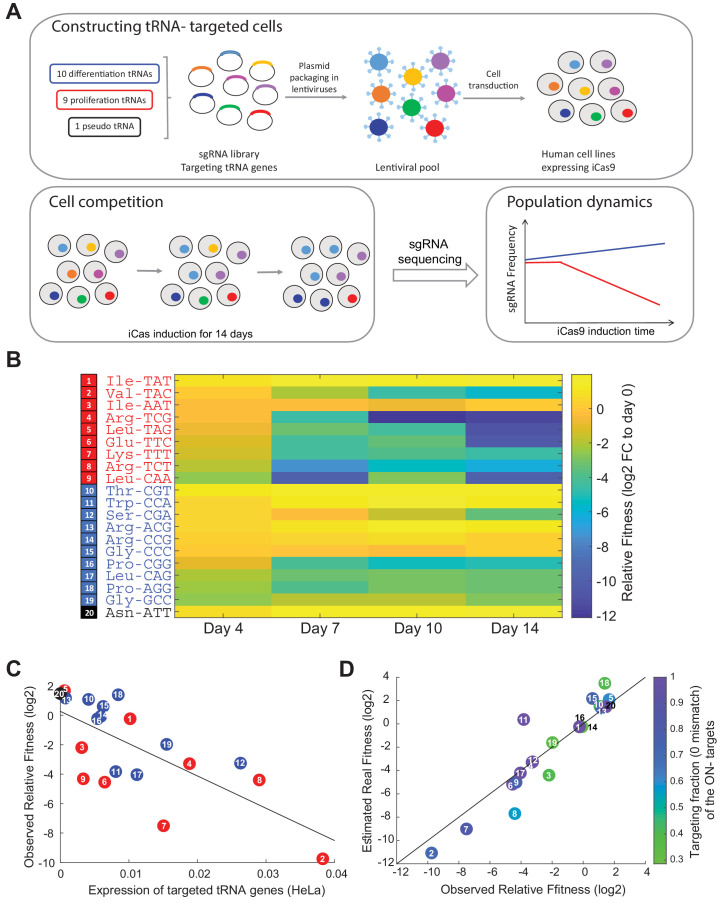
Proliferation-tRNA are essential for cellular growth in HeLa cells.(A) The experimental design. We designed a CRISPR-sgRNA library, in which each sgRNA targets specific tRNA gene family. Overall, we targeted nine proliferation-tRNAs, 10 differentiation- tRNAs and one pseudo tRNA family. Following cloning of the sgRNAs into a lenti-plasmid, we produced a lenti-viral pool that contained the entire sgRNA pool. Then, we transduced human cell lines (HeLa, WI38 fast and WI38 slow) expressing an inducible Cas9 with the lenti-viral sgRNA pool. We performed a CRISPR-edited tRNA cell competition by induction of the iCas9 in parallel to antibiotic selection (two biological repeats for each cell line). The iCas9 induction continued for 14 days, during which we sampled the heterogonous population every 3–4 days. Lastly, we deep-sequenced the sgRNAs in each sample, to evaluate the growth dynamics of the targeted-tRNA cells. (B) A heat map representation of the relative fitness of CRISPR-targeted tRNA variants in HeLa cells. Each row represents a CRISPR-targeted tRNA variant, colored according to the tRNA classification (proliferation-tRNAs in red, differentiation-tRNAs in blue and pseudo tRNA in black). Each column represents a time point during the iCas9 induction. The color code depicts a proxy of each row’s relative fitness - fold-change (log2) of the sgRNA read frequency in each time point relative to the sgRNA read frequency in day 0 of the iCas9 induction (see Materials and methods). The values were averaged over two biological repeats. (C) A scatter plot of the correlation between the expression of tRNAs in WT HeLa cells and their relative fitness upon CRISPR-targeting (regression model, relative fitness as a linear function of tRNA expression, had a slope of −219.5 and intercept of 0.26; Pearson correlation, r = −0.71, p<10−3). Expression levels for each targeted tRNA families is summed over all isodecoder genes of the family and is averaged over two biological repeats. Observed relative fitness of the CRISPR-targeted tRNA cells is shown given frequency of each tRNA family in day 7 of the competition. The colors and numbers denote the tRNA group. (D) Shown here is the estimated real relative fitness (log2) of each tRNA-targeted HeLa cells based on the observed relative fitness (log2), using a linear equation system. The observed and estimated real essentiality are correlated (regression model, estimated real relative fitness as a linear function of observed relative fitness, had a slope of 1.19 and intercept of 0.37; Pearson correlation, r = 0.93, p<10−5). The color code depicts the fraction of isodecoder genes of each ON-target tRNA family with full complementarity to the respective sgRNA. tRNA numbering in sub figures C and D is identical to those presented in sub figure B.